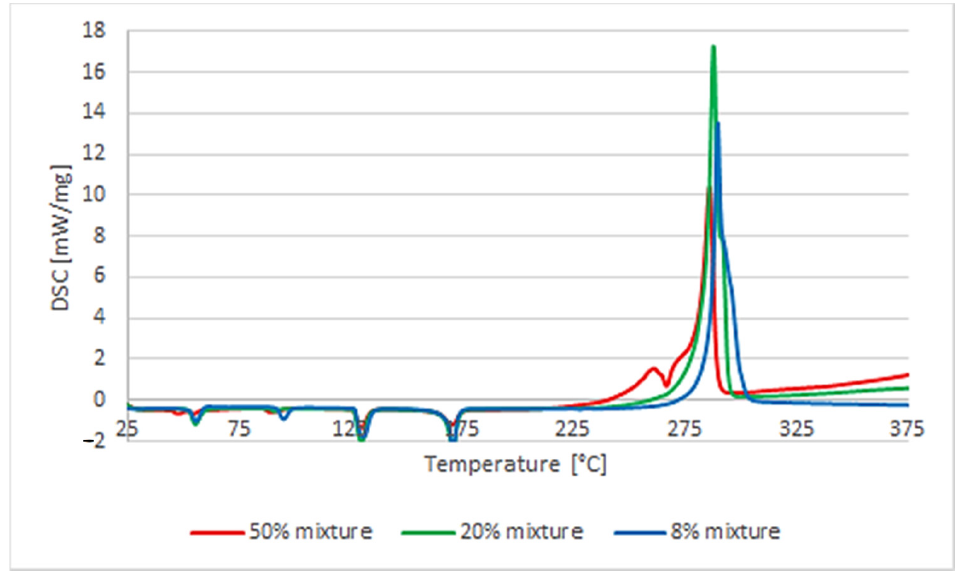
Figure 9. DSC analysis of AN and PMMA mixture composition influence on their thermal properties, heat rate 10 °C/min. Table 4. Results of DSC analysis of AN and soft PMMA mixture with different proportions.